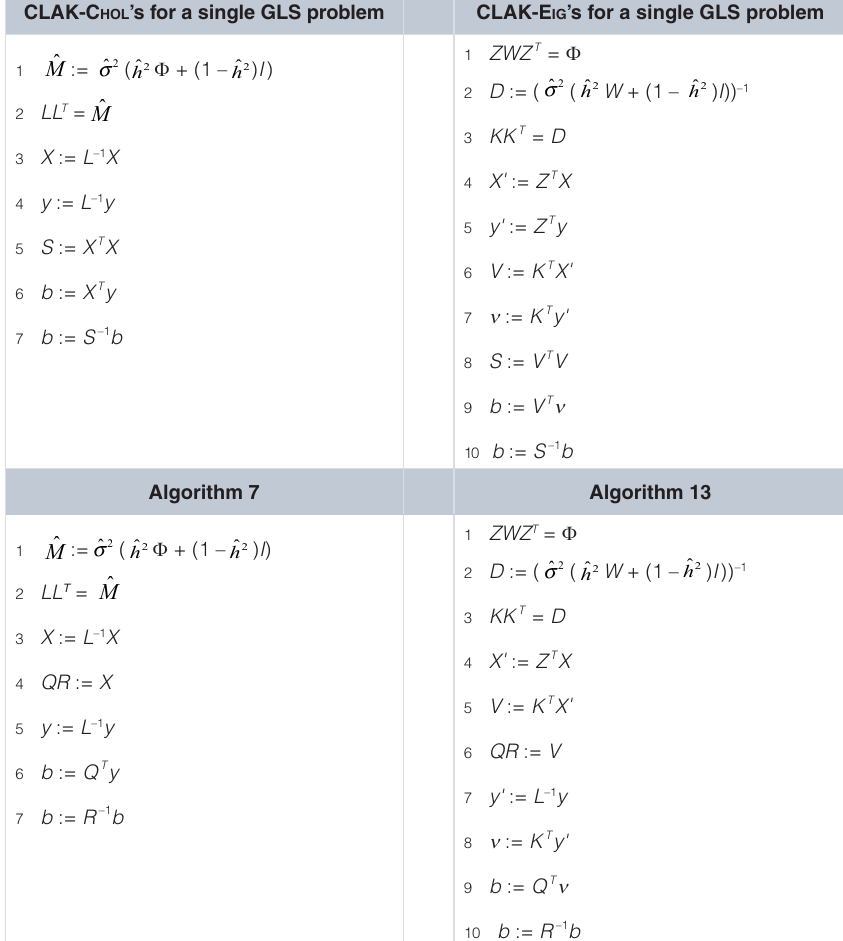
CLAK-C hol ’s for a single GLS